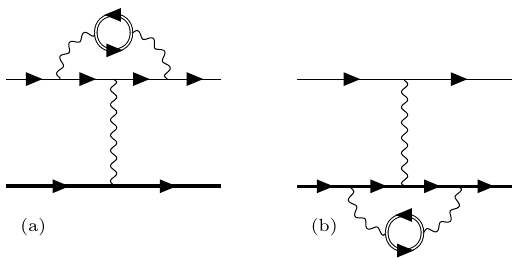
Figure 5. NNLO irreducible vertex diagrams. Vertex correction along the electron line (left) and along the muon line